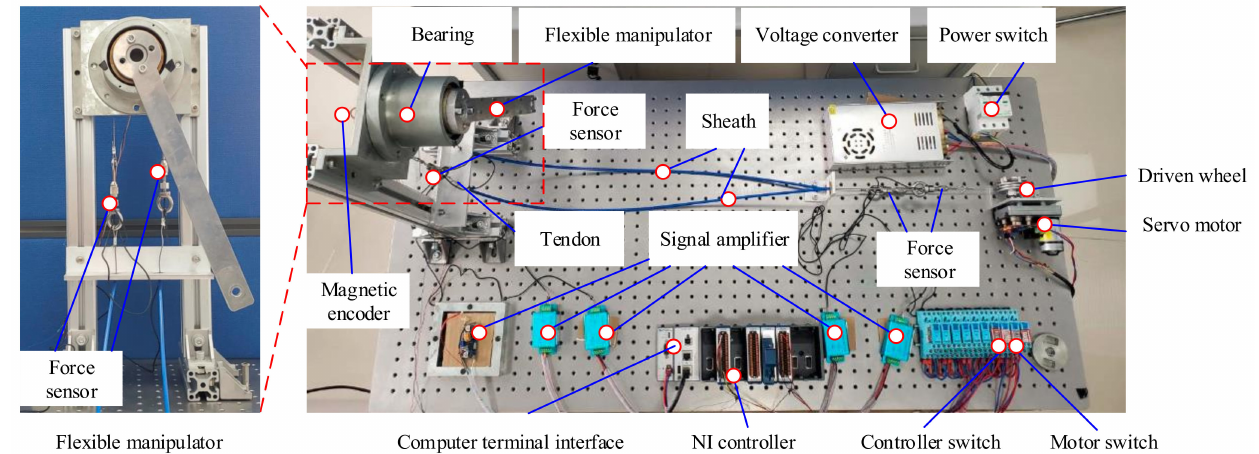
Figure 14. Experimental platform of the flexible manipulator.